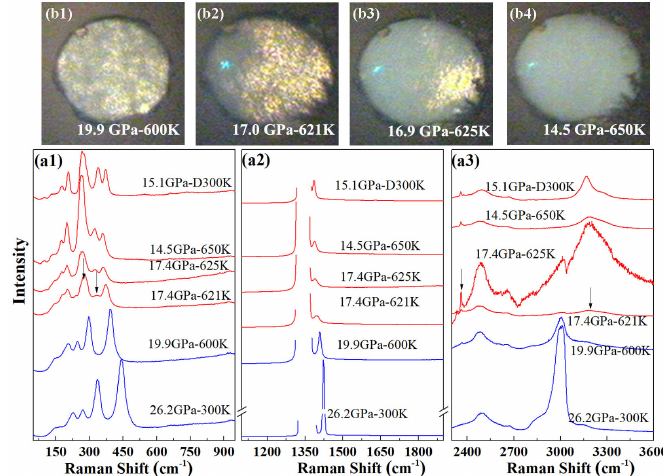
Figure 4. High P - T transformation of pure AA. ( a ) Raman spectra collected before (blue lines) and during (red lines) the transformation (621–650 K). The uppermost spectrum was collected after cooling back to 300 K. The arrows in the figure indicate the positions of new peaks. “D” indicates that the measurement was performed on decreasing temperature; ( b ) Photographs of the sample chamber before (600 K) and during the transformation (621–650